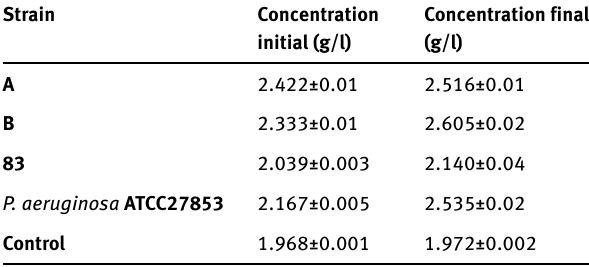
Table 2: Results of DNS method to detection reducing sugars